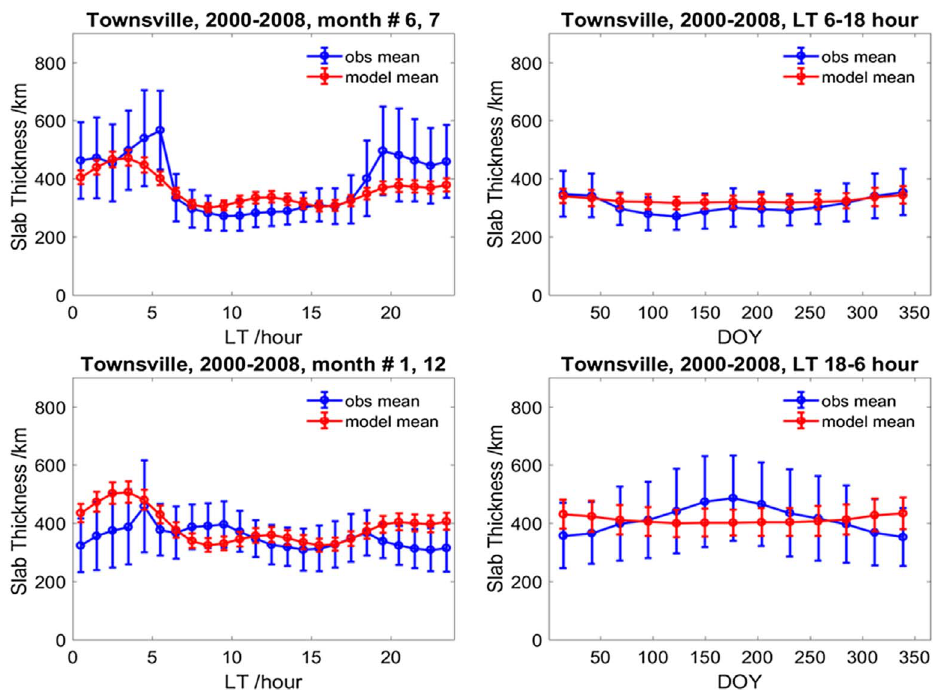
Fig. 12. Diurnal and seasonal variation of the observed and modelled s over Townsville for summer (June/July) and winter (December/ January) conditions and for day (6 – 18 LT) and nighttime (18 – 6 LT) conditions, respectively.